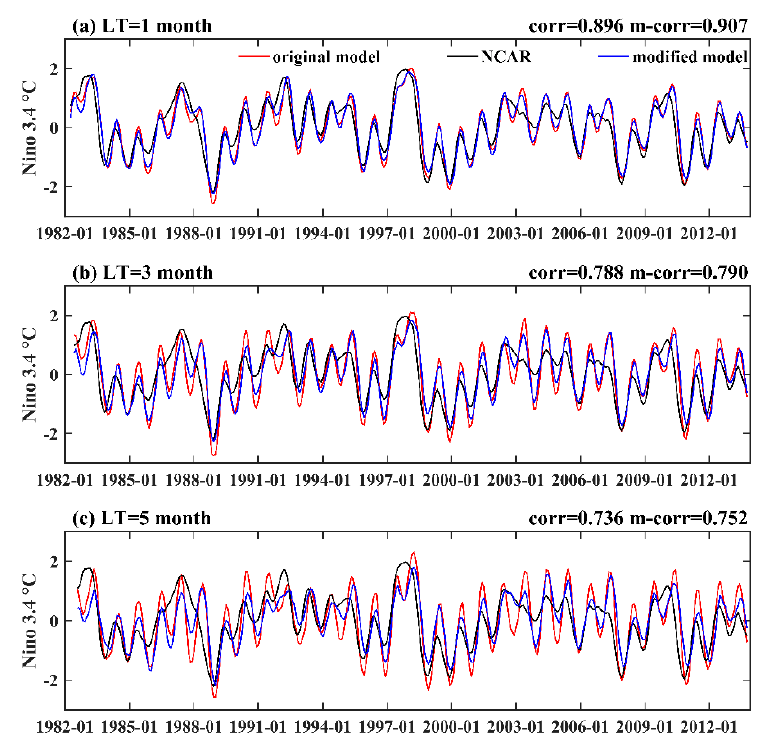
Figure 3. Time series of Niño 3.4 index values predicted by observation (black), FIO − ESM − CPS (red line) and modified FIO − ESM − CPS (blue line) at ( a ) 1 - , ( b ) 3 - , and ( c ) 5 - month lead times (unit: 1).